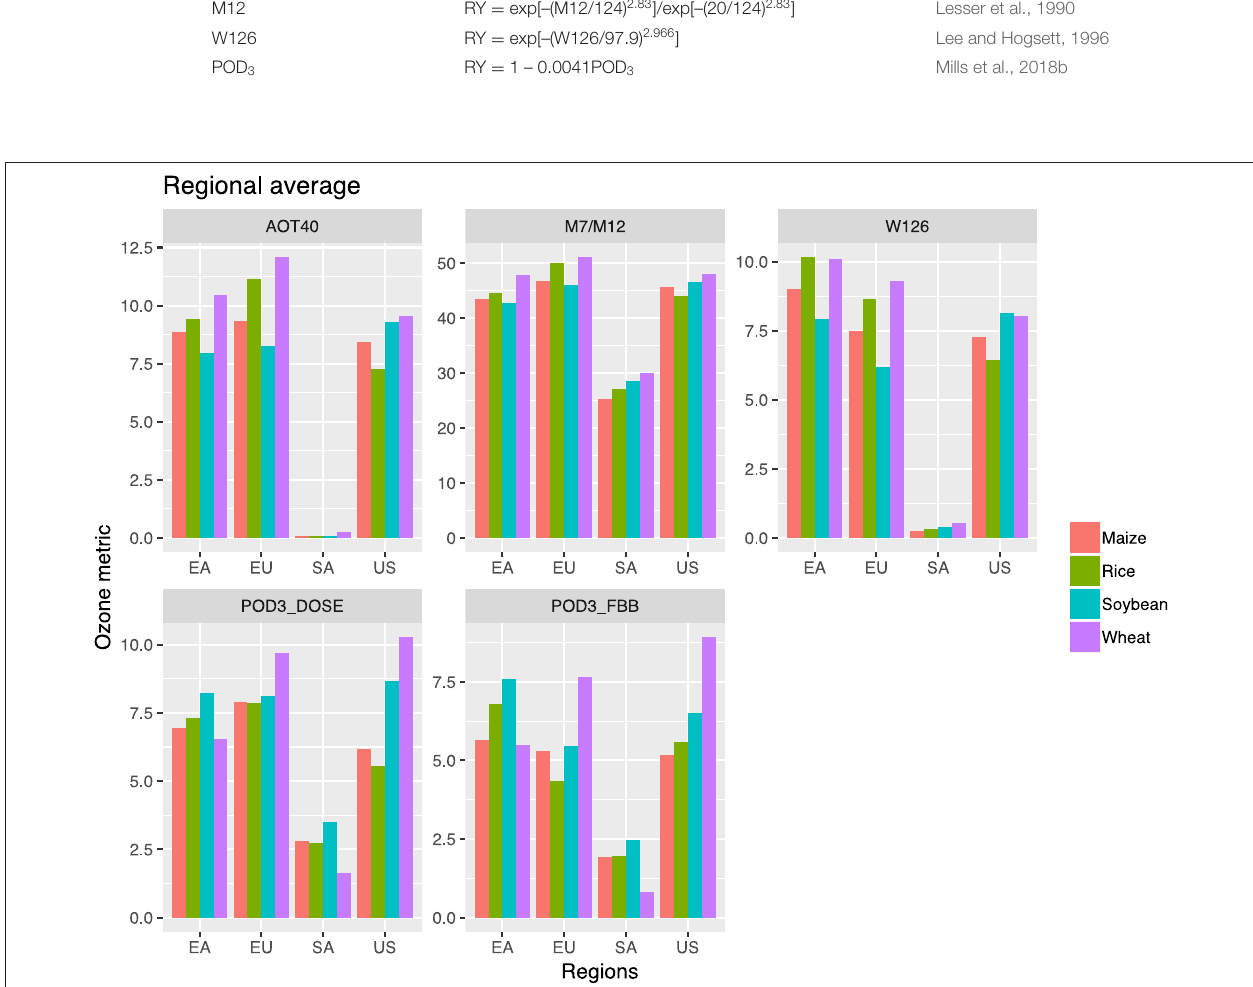
FIGURE 4 | Regional average O 3 metric values for East Asia (EA), Europe (EU), South America (SA), and United States (US). Units: ppm-h for AOT40, W126; ppb for M7/M12; mmol m − 2 for POD 3 -DO 3 SE, POD 3 -FBB.